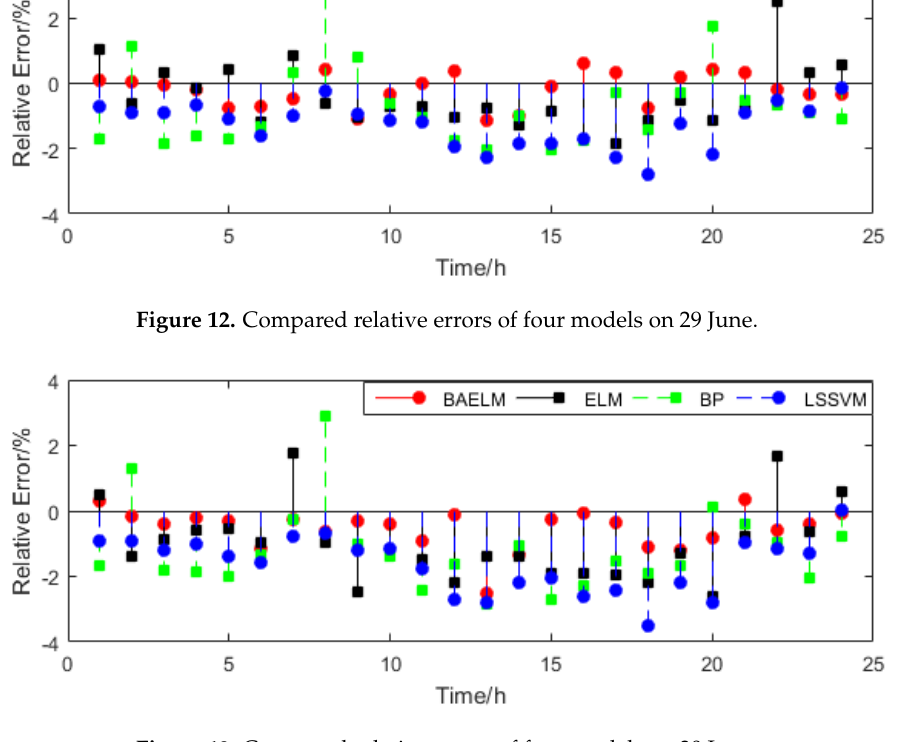
Figure 13. Compared relative errors of four models on 30 June. Table 7. Actual load and forecasting results on Day 1 (Unit: MV).